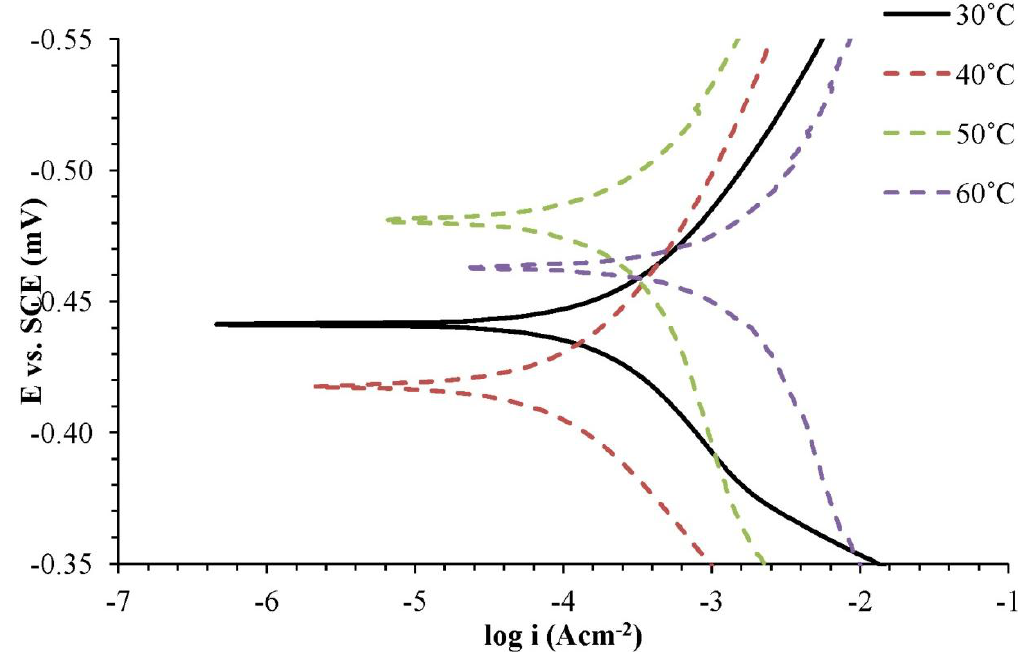
Figure 4. Potentiodynamic polarization curve for mild steel in 1.0 M H of the corrosion inhibitor at different temperatures.